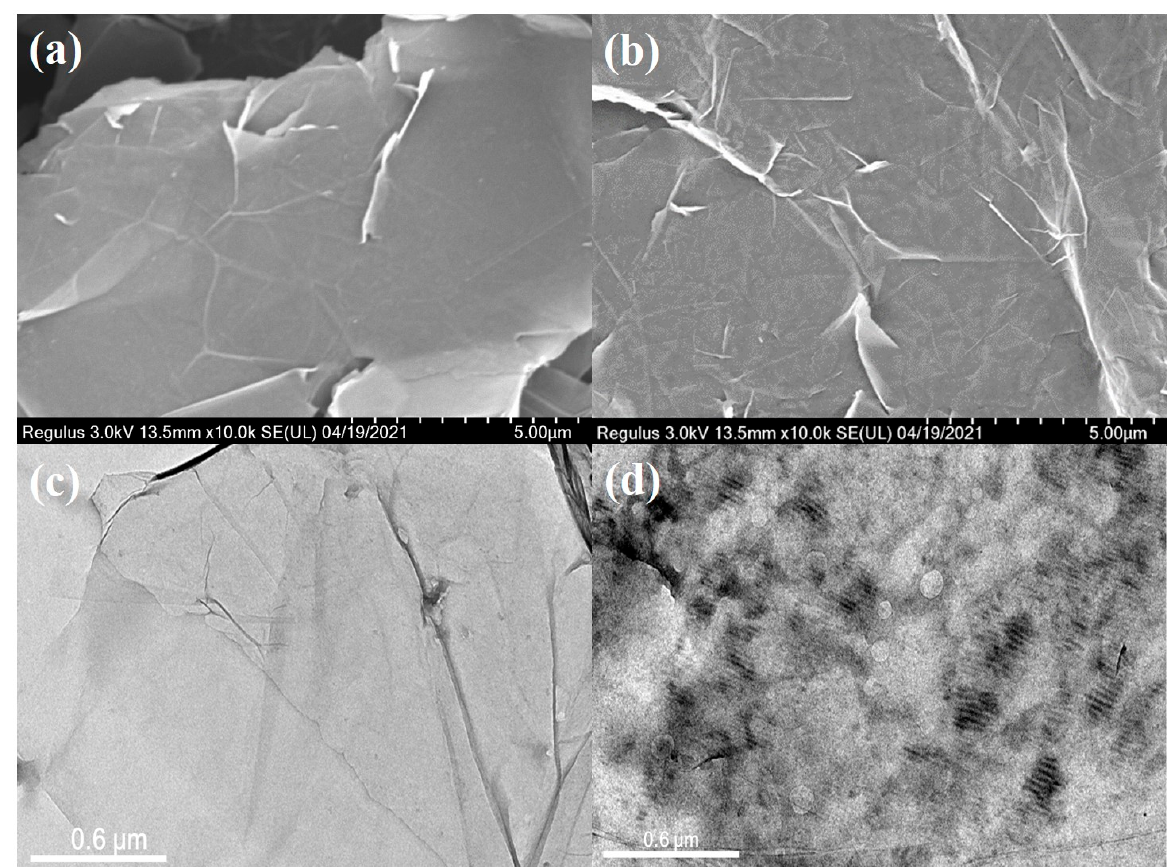
Figure 6. ( a ) Scanning electron microscopy (SEM) images of GNS. ( b ) SEM images of GNS@P3HT (6000). ( c ) Transmission electron microscopy (TEM) images of GNS. ( d ) TEM images of GNS@P3HT (6000).